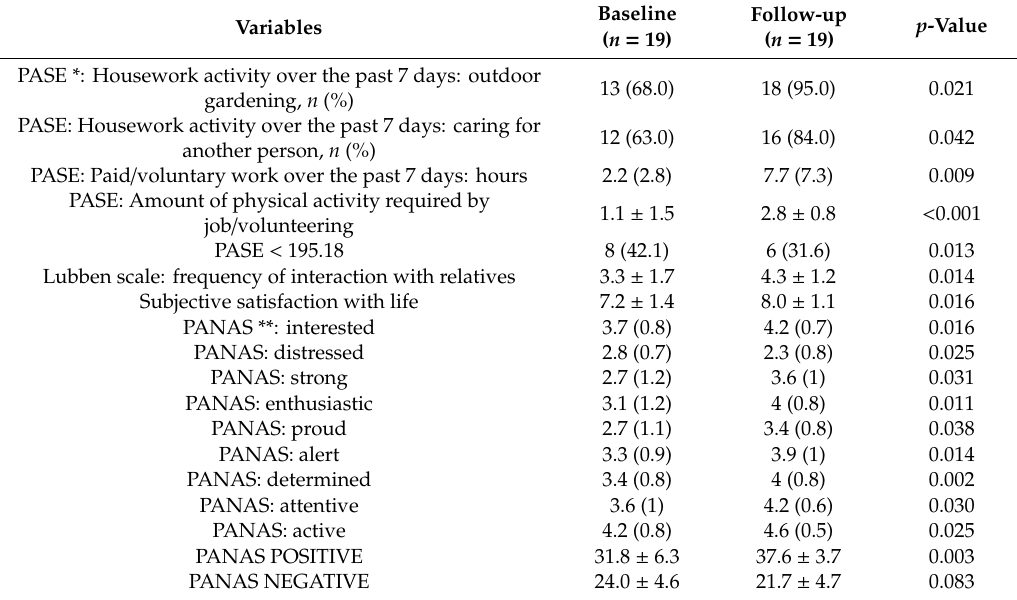
Table 2. Pre- and post-program significant